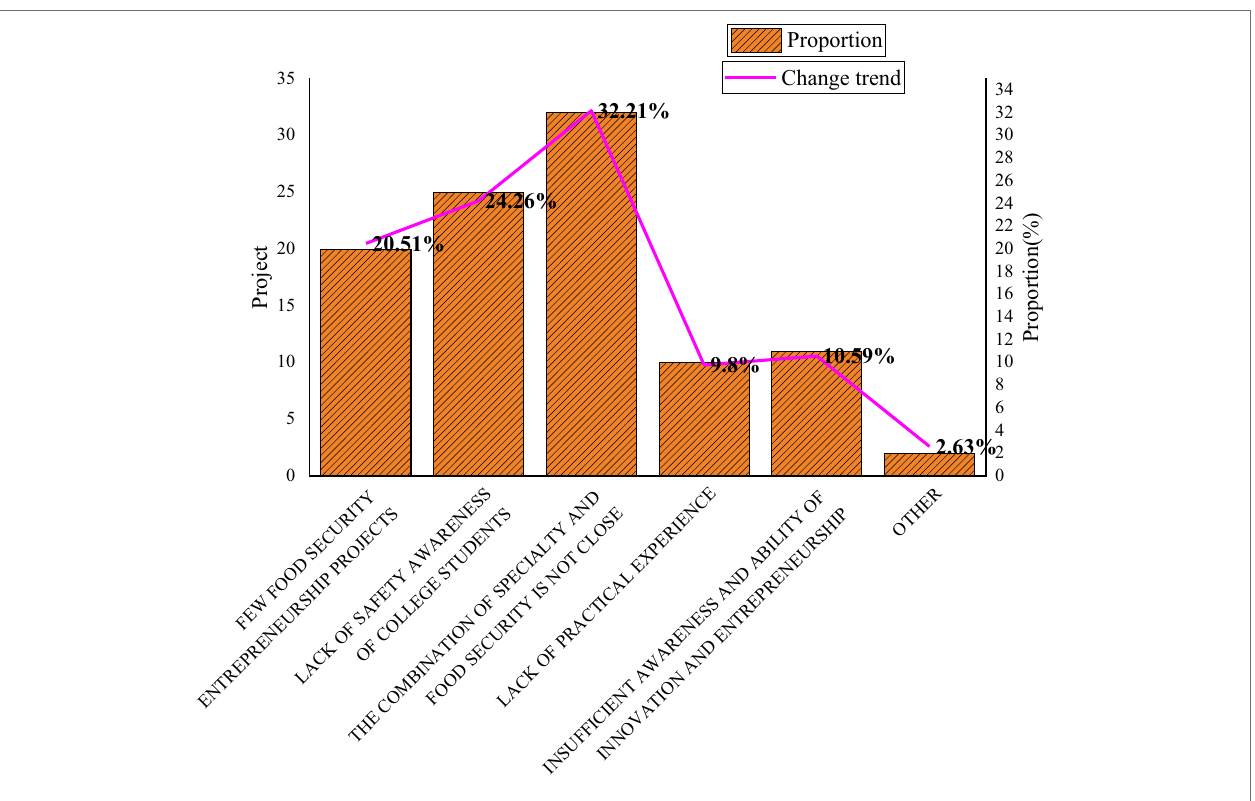
FIGURE 8 | College teachers and students’ perception of food